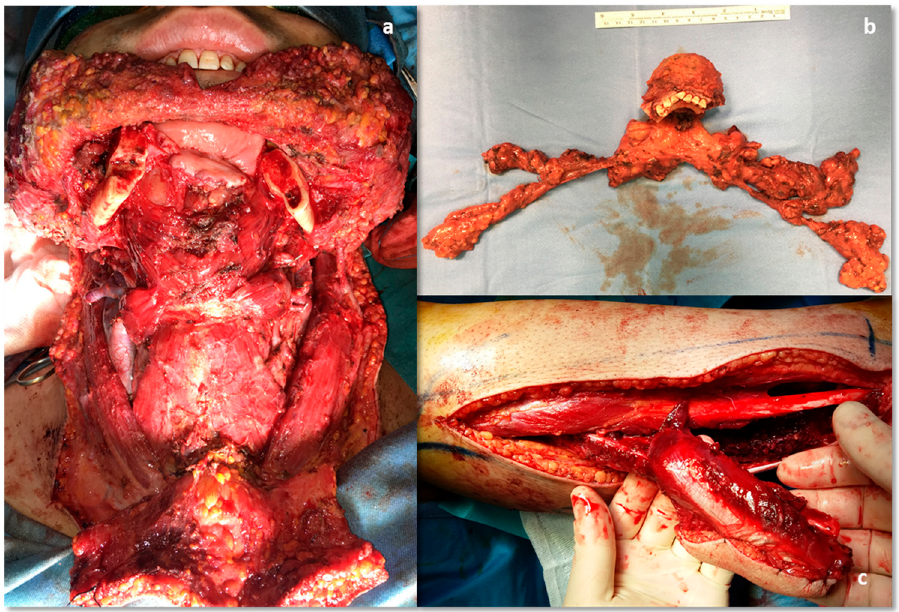
Figure 8. Osteotomy cutting guides.